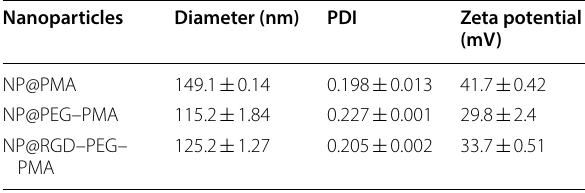
Table 4 Physicochemical properties of nanoparticles